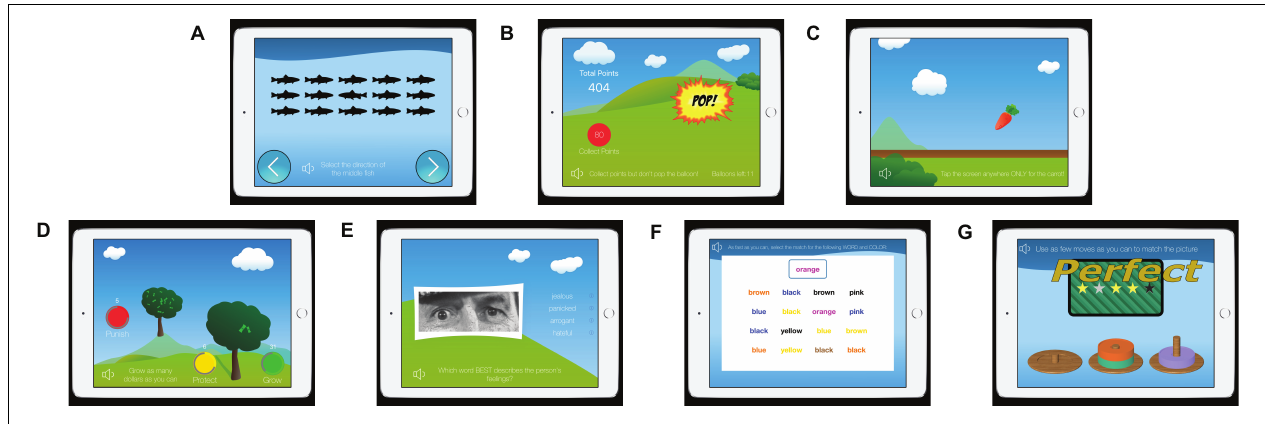
FIGURE 1 | Screenshots of the NeuroCognitive Risk Assessment (NCRA): (A) the Eriksen Flanker, (B) Balloon Analog Risk Task, (C) Go/No-Go, (D) Point-Subtraction Aggression Paradigm, (E) Reading the Mind Through the Eyes, (F) Emotional Stroop, and (G) Tower of London (Ormachea et al., 2017).